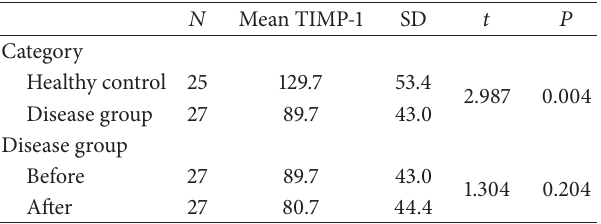
Table 1: Correlation between TIMP-1 levels in healthy control groupandperiodontallydiseasedgroupbeforeandafternonsurgical periodontal therapy.